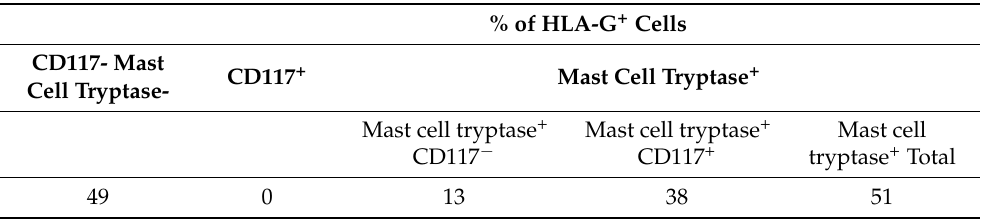
Table 2. Nature of HLA-G + cells expressed as a percentage following quadruple staining (DAPI/HLA-